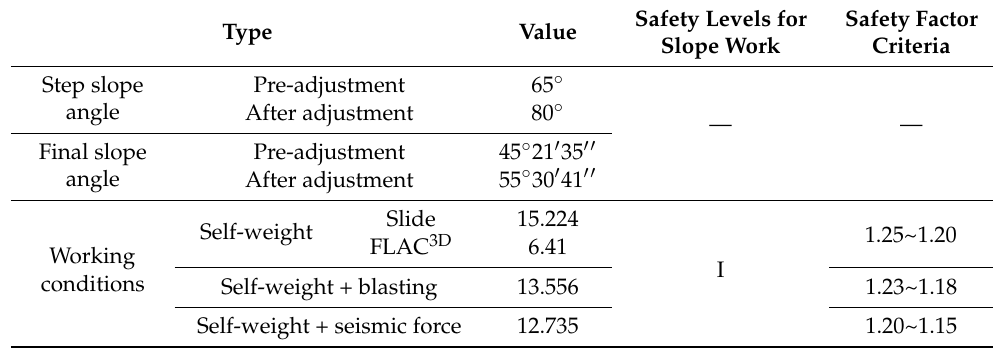
Figure 12. Results of the adjusted R3 slope for the limit equilibrium method: ( a ) self ‐ weight; ( b ) self ‐ weight + blasting; ( c ) self ‐ weight + seismic force. Table 12. Summary of the results of the adjusted R3 slope stability analysis.